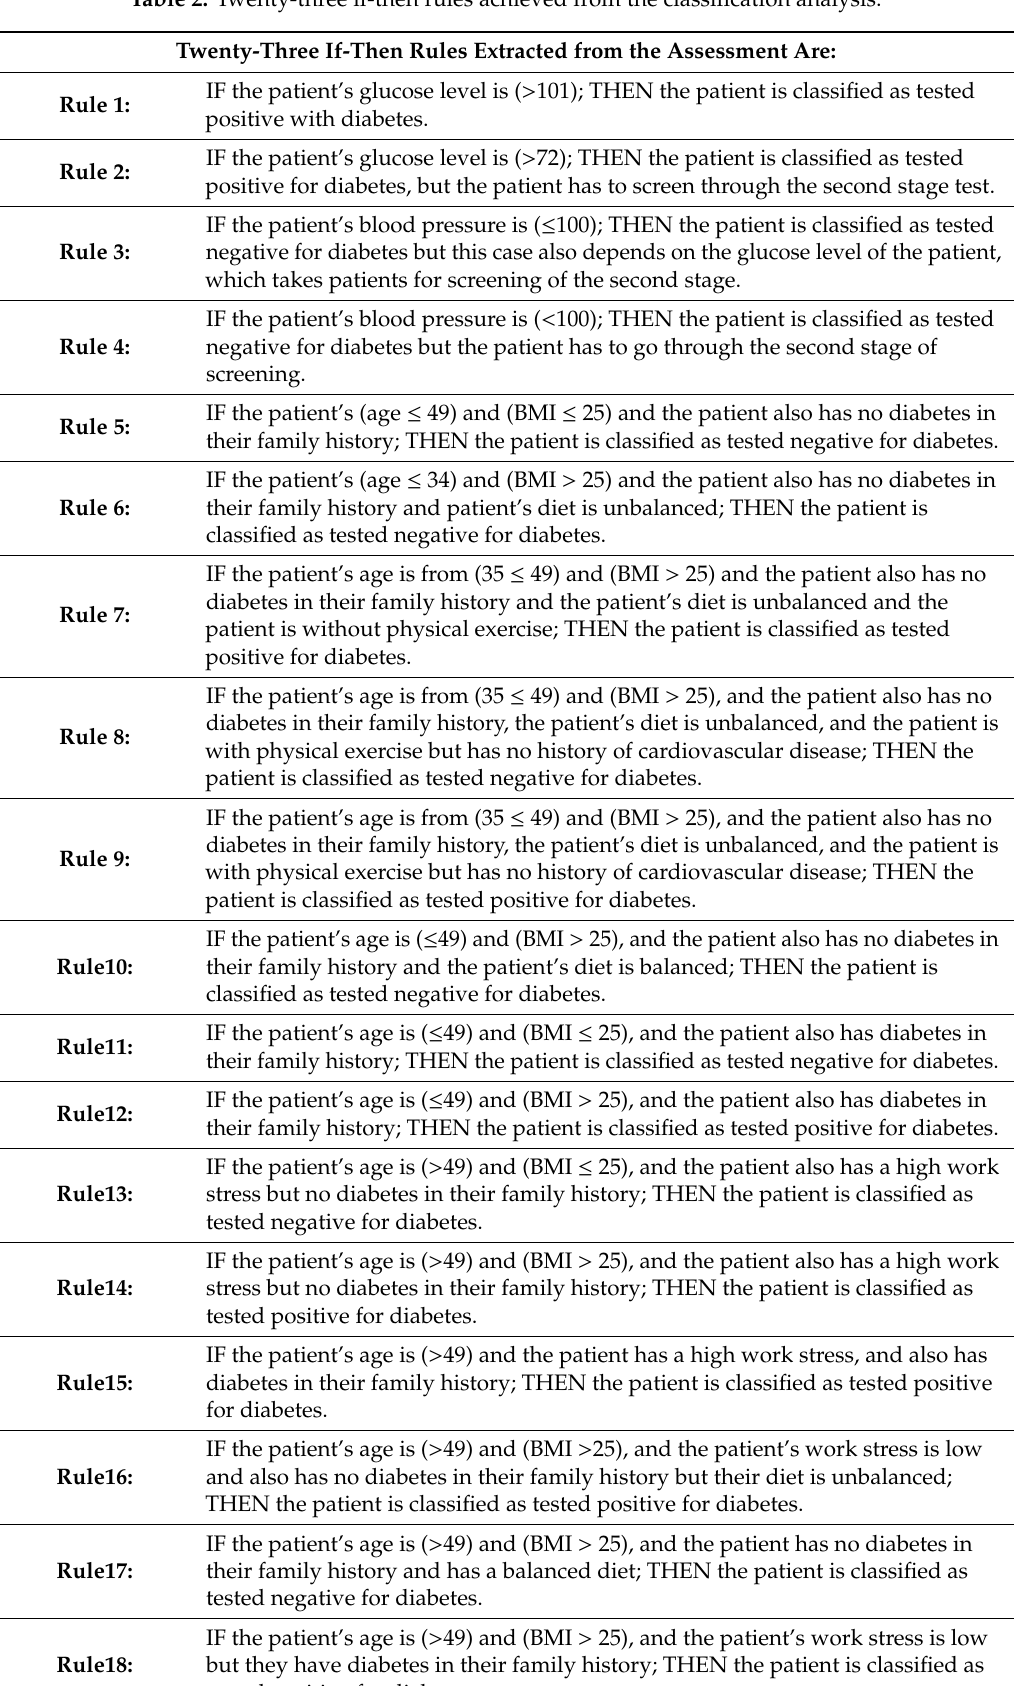
Table 2. Twenty-three if-then rules achieved from the classification analysis. Twenty-Three If-Then Rules Extracted from the Assessment